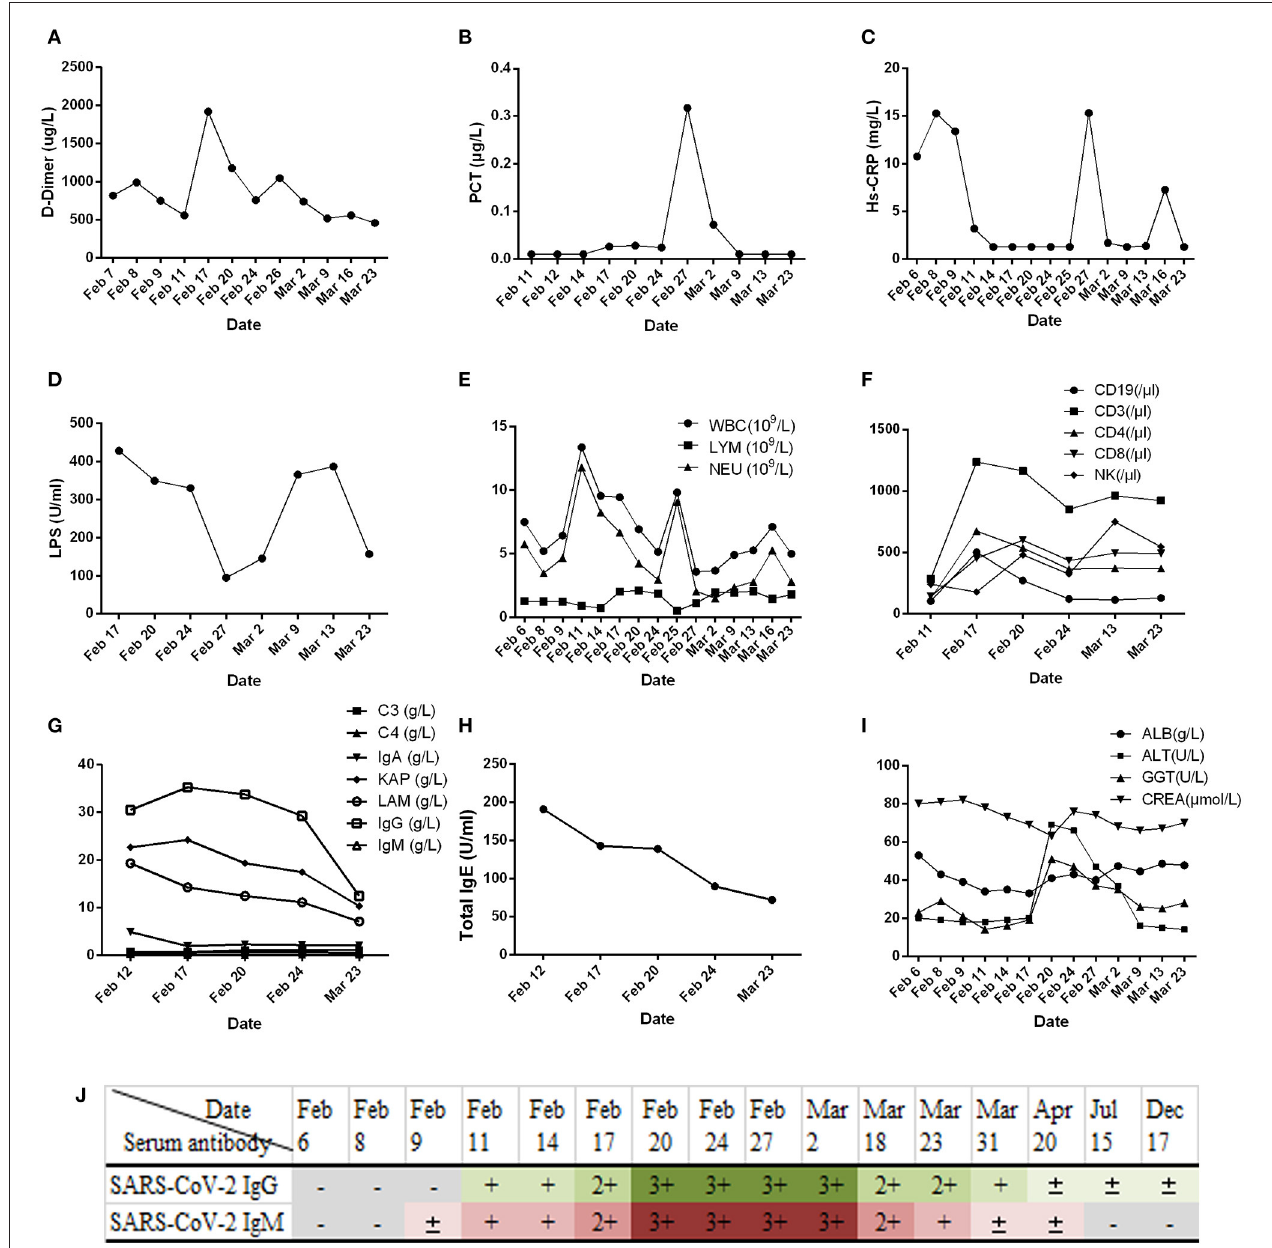
FIGURE 2 | Results of routine laboratory examination of patients with COVID-19 during admission. (A) Plasma D-dimer; (B) serum procalcitonin (PCT); (C) high-sensitivity C-reactive protein (Hs-CRP); (D) lipopolysaccharide (LPS); (E) white blood cell count; (F) classification count of lymphocyte subsets; (G) complement (C3, C4), immunoglobulin (IgA, IgG, IgM), and light chain (KAP, LAM: Immunoglobulin light chain kappa and lambda); (H) immunoglobulin E (IgE); (I) liver (ALB, albumin; ALT, alanine aminotransferase; GGT, gamma glutamyl transpeptidase) and kidney function (CREA, creatinine); (J) results of serum SARS-CoV-2 IgG/IgM detection in patients with COVID-19. The SARS-CoV-2 serum antibody (IgG/IgM) test kit (colloidal gold method) was provided by Zhuhai Lizhu Reagent Co., Ltd.; “–” represents negative, “ ± ” represents weak positive, and “ + , 2 + , 3 + ” represents positive, and it was enhanced step by step.